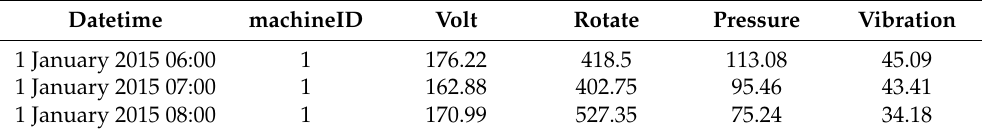
Table 1. An example of machine conditions and usage date i.e., telemetry which includes information about time (“Datetime”), machine (“machineID”), and the sensors data consisting of voltage (“Volt”), rotation (“Rotate”), pressure (“Pressure”) and vibration